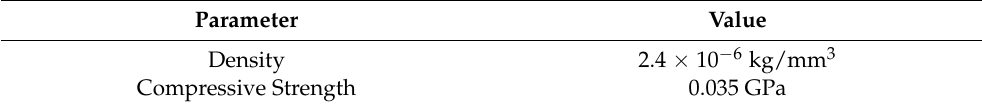
Table 3. Concrete materials properties (K&C model).